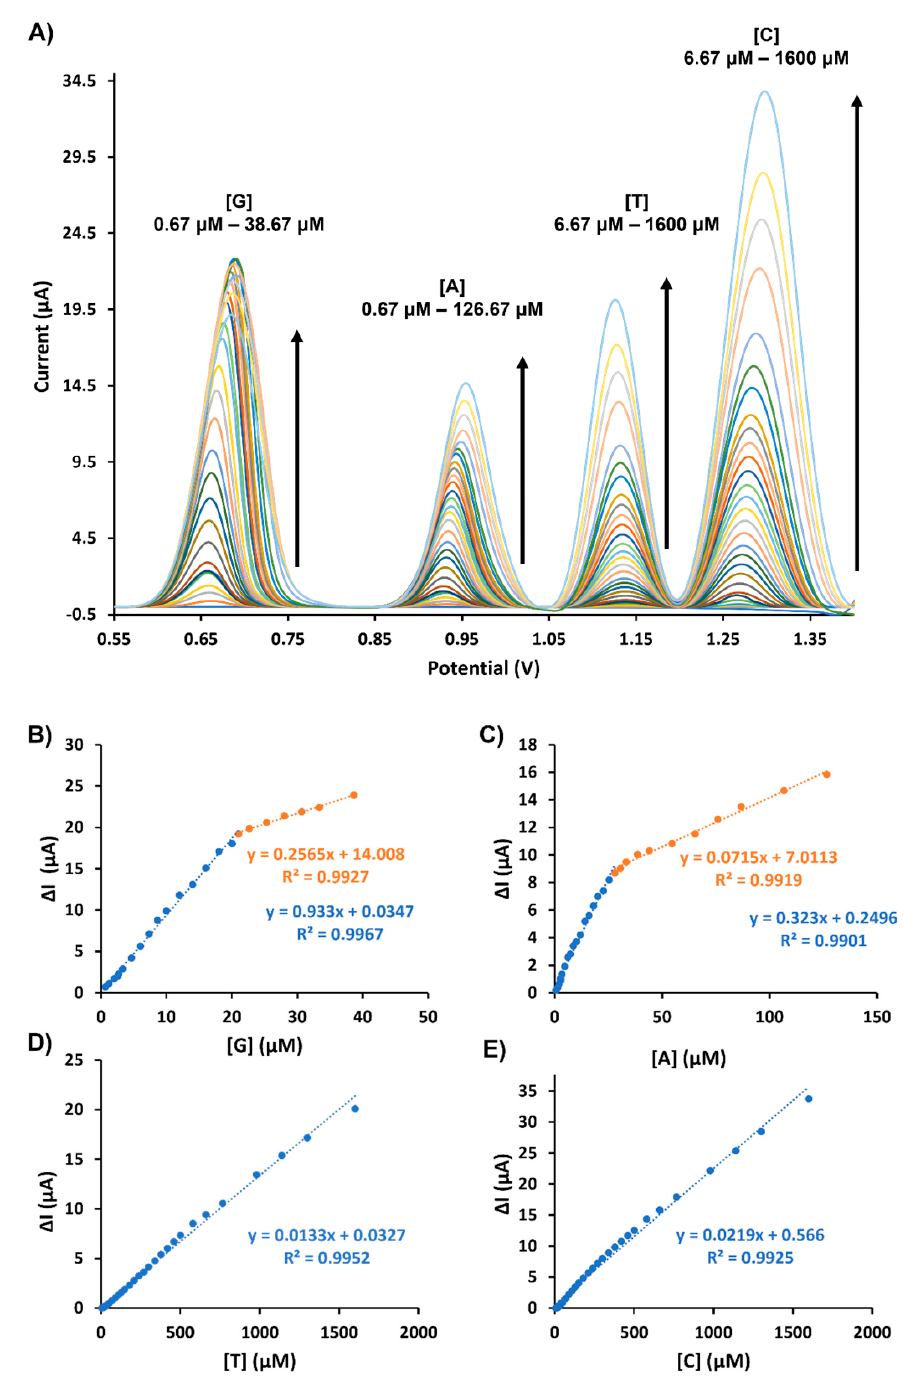
Figure 5. ( A ) An overlay of voltammograms representing the calibration curves for the simultane- ous detection of G, A, T, and C using DPV at the GPE-SC-MB. Calibrations plots for ( B ) guanine, ( C ) adenine, ( D ) thymine, and ( E ) cytosine. Table 2. Equations representing the linear plots for the four DNA bases along with their regression coefficients, LODs, and LOQs. Δ I p refers to the current after background subtraction.